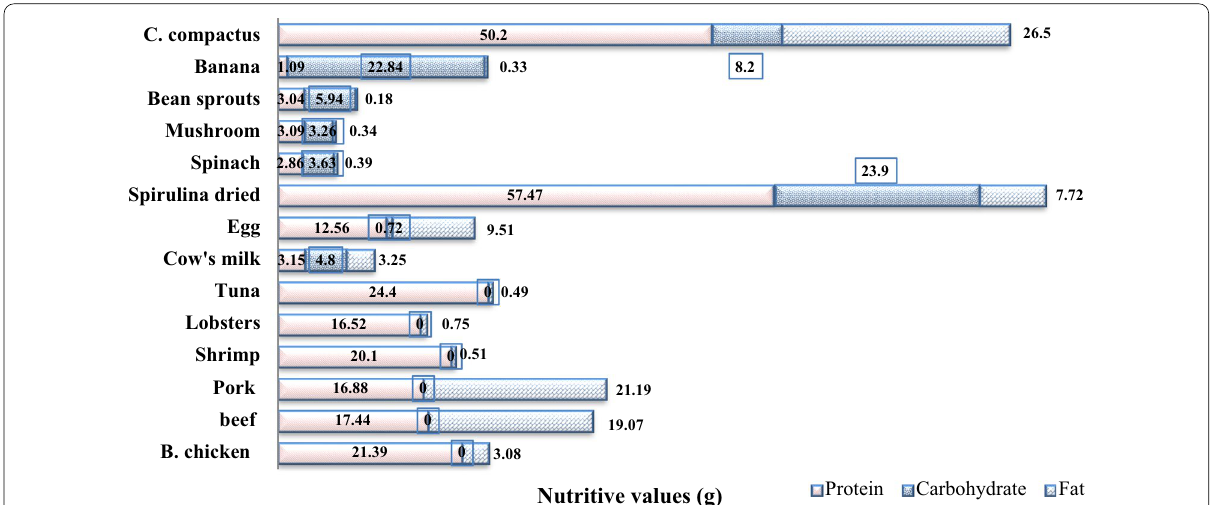
Fig. 7 Graph showing comparison of the proximate composition of Coiblemmus compactus and other food sources (Source: USDA Food data central